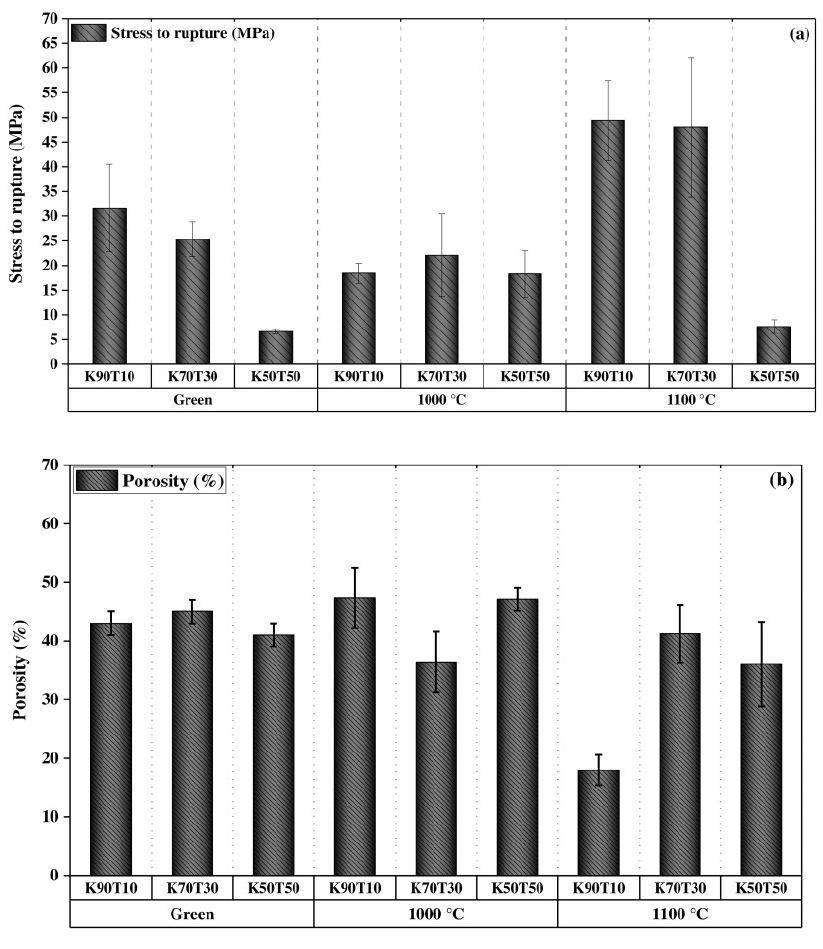
Figure 9. Comparative values of ( a ) the stress to rupture and ( b ) the apparent porosity of kaolin–talc tapes before and after sintering at 1000 and 1100 °C.